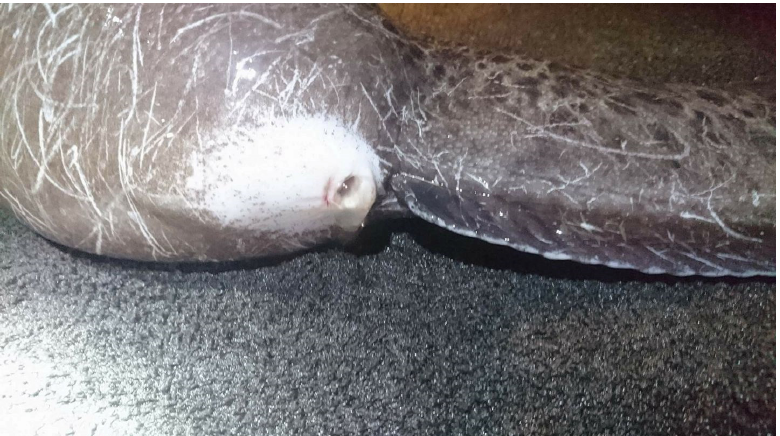
Figure 4. Ventral view of a female with a wide genital opening (>5 mm) and observable release of ovarian fluid. The large round belly is also clearly visible. Picture obtained before manual collection of the eggs. Source: Beirao, J.